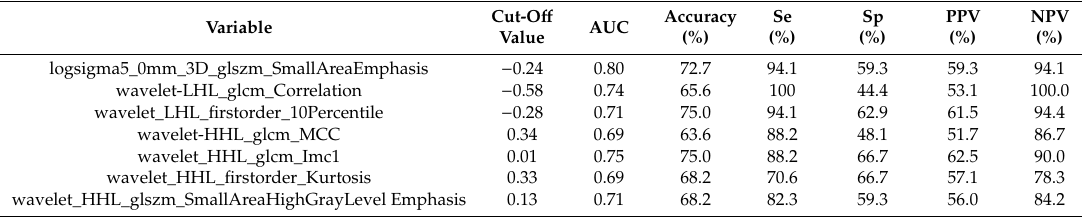
Table 3. Individual diagnostic performance of the selected radiomics features.